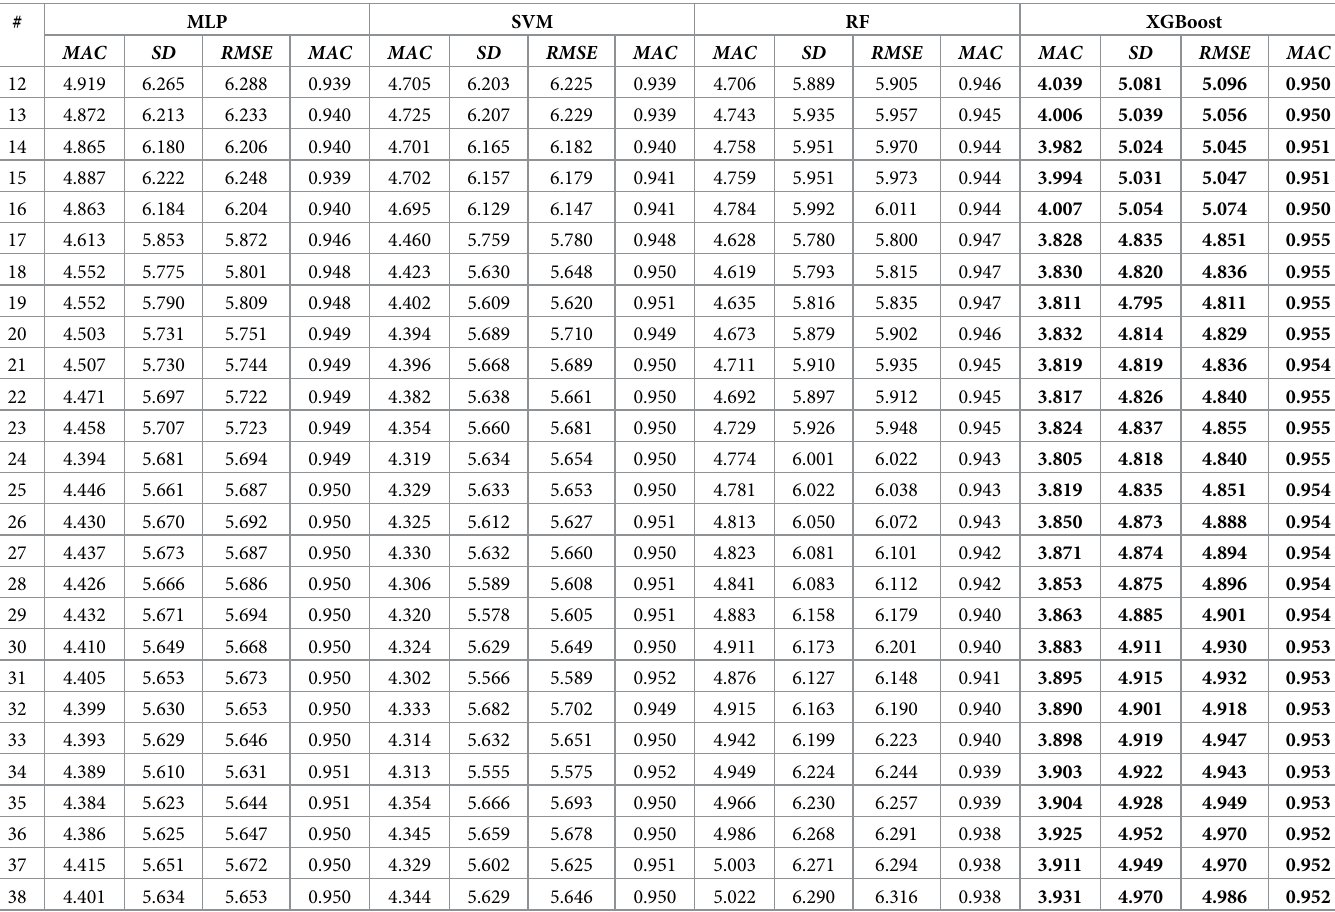
Table 13. Experimental results for the MLP, SVM, RF, and XGBoost, based on the NHANES dataset, with ICA feature extraction (best results are highlighted in bold; # means the number of